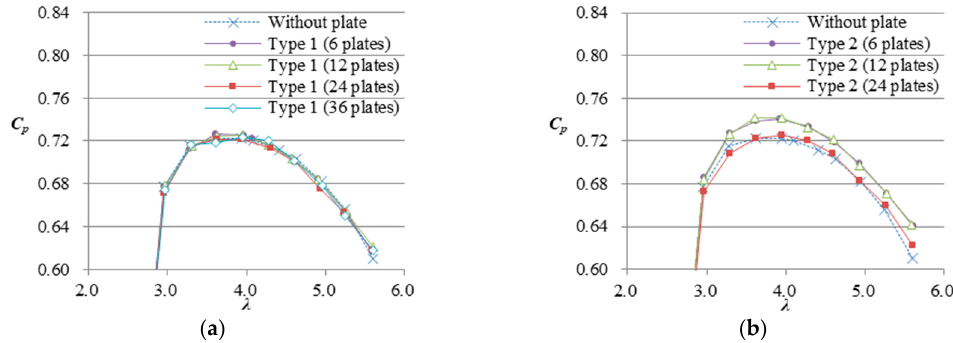
Figure 10. Power curves of WLT Ci05: ( a ) Results of the WLT with the type 1 vortex stabilizing plates; ( b ) Results of the WLT with the type 2 vortex stabilizing plates.